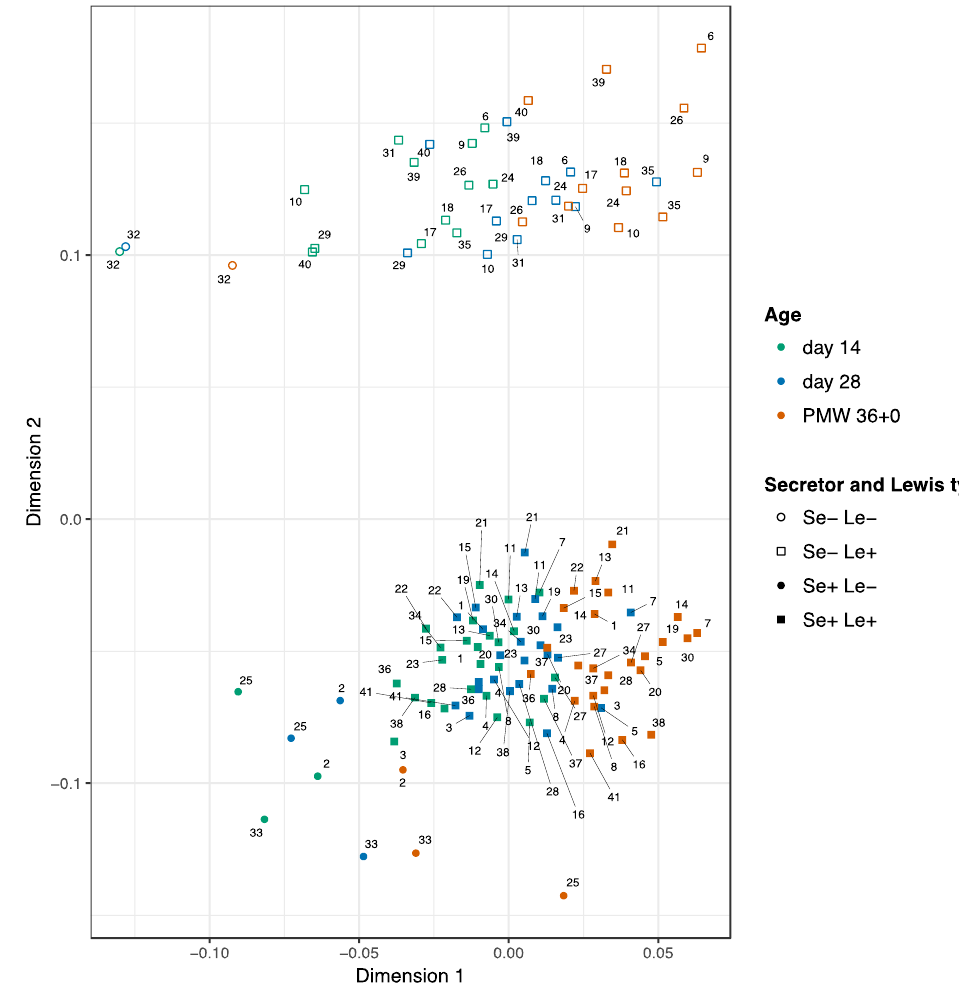
Figure 1. Non-metric multidemension scaling (NMDS) plot of the HMO composition among the 41 mothers with samples from all three time points. Each mother is indicated by a number from 1 to 41. PMW 36+0: postmenstrual week 36+0. Stress level: 0.08